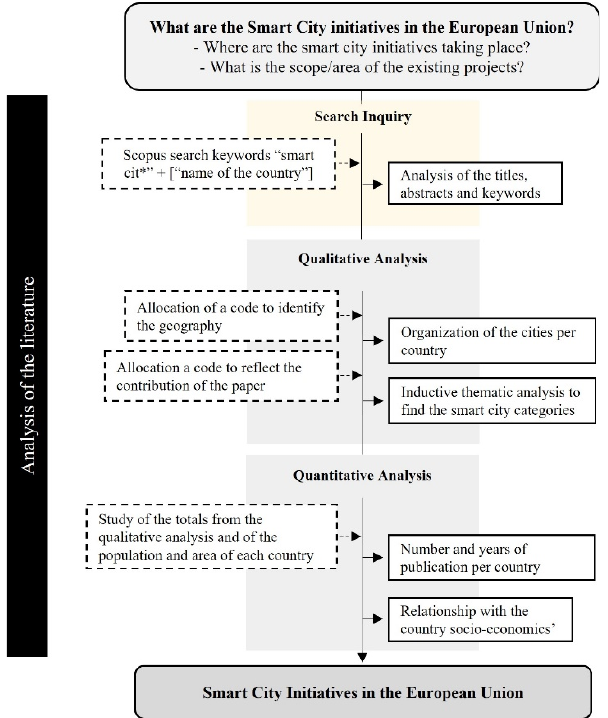
Figure 1. Methodological approach to analyze smart city initiatives in the EU.